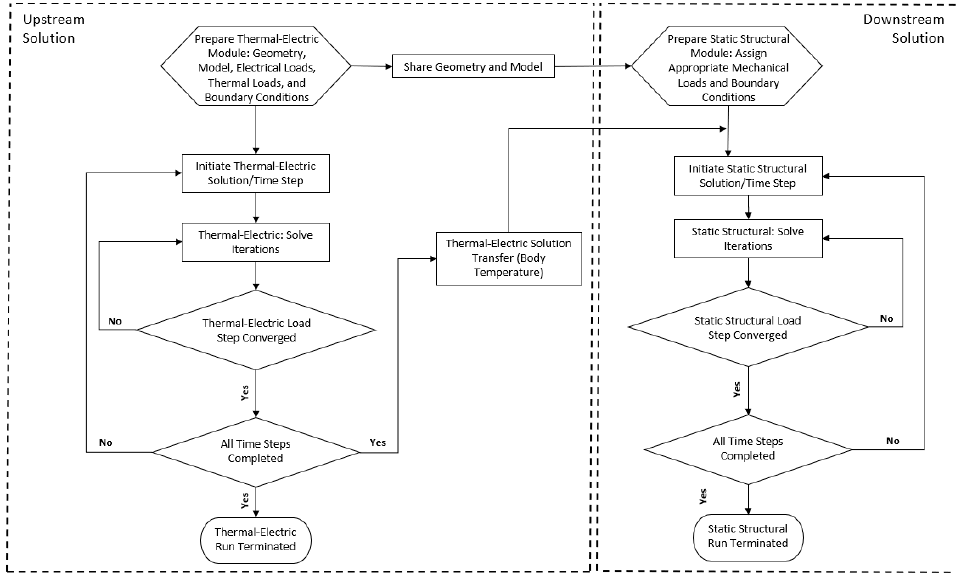
Figure 4. Sequential-coupling process flow execution. The upstream thermal-electric module ( left ) is initiated by the definition of the problem geometry and its discretisation, together with the assignment of loads (thermal and/or electric) and boundary conditions (typically thermal). Following the model definition, the method proceeds to solving all iterations and load steps. Once the solution has converged, the upstream run is terminated. The geometry and model from the upstream solution are shared with the downstream structural module ( right ), where structural loads and boundary conditions are applied as necessary. The body temperature as calculated in the upstream model is also added to the downstream as a thermal load. The downstream module proceeds to solving all iterations and load steps and once the solution has converged, the downstream run is terminated, following which, the evaluation of thermal stresses and strains is possible. All sequentially coupled analyses are implemented in Ansys ® Academic Research Mechanical, Release 21.1.